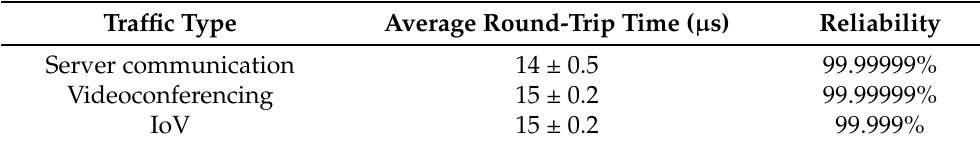
Table 3. The average round-trip time and the reliability of traffic in the three scenarios.